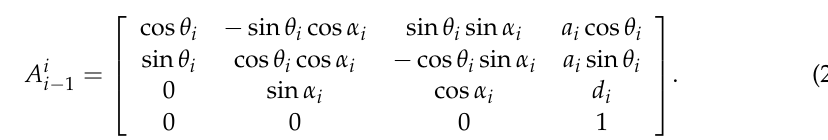
and joint offset 𝜑 (cid:3036) (for the joints driven by the swing cylinder, 𝛽 (cid:3036) is the swing angle).